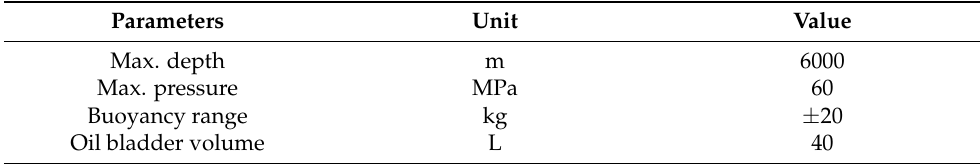
Table 2. Designed parameters of deep-sea